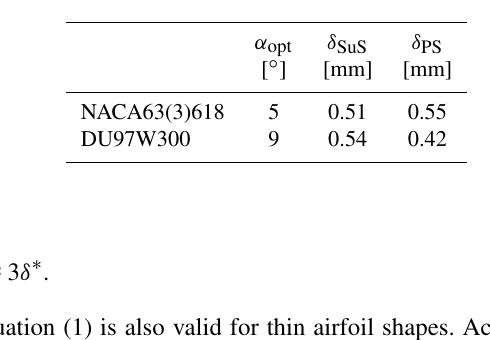
Table 3. XFOIL simulations of the boundary layer thickness ac- cording to Eq. (1).